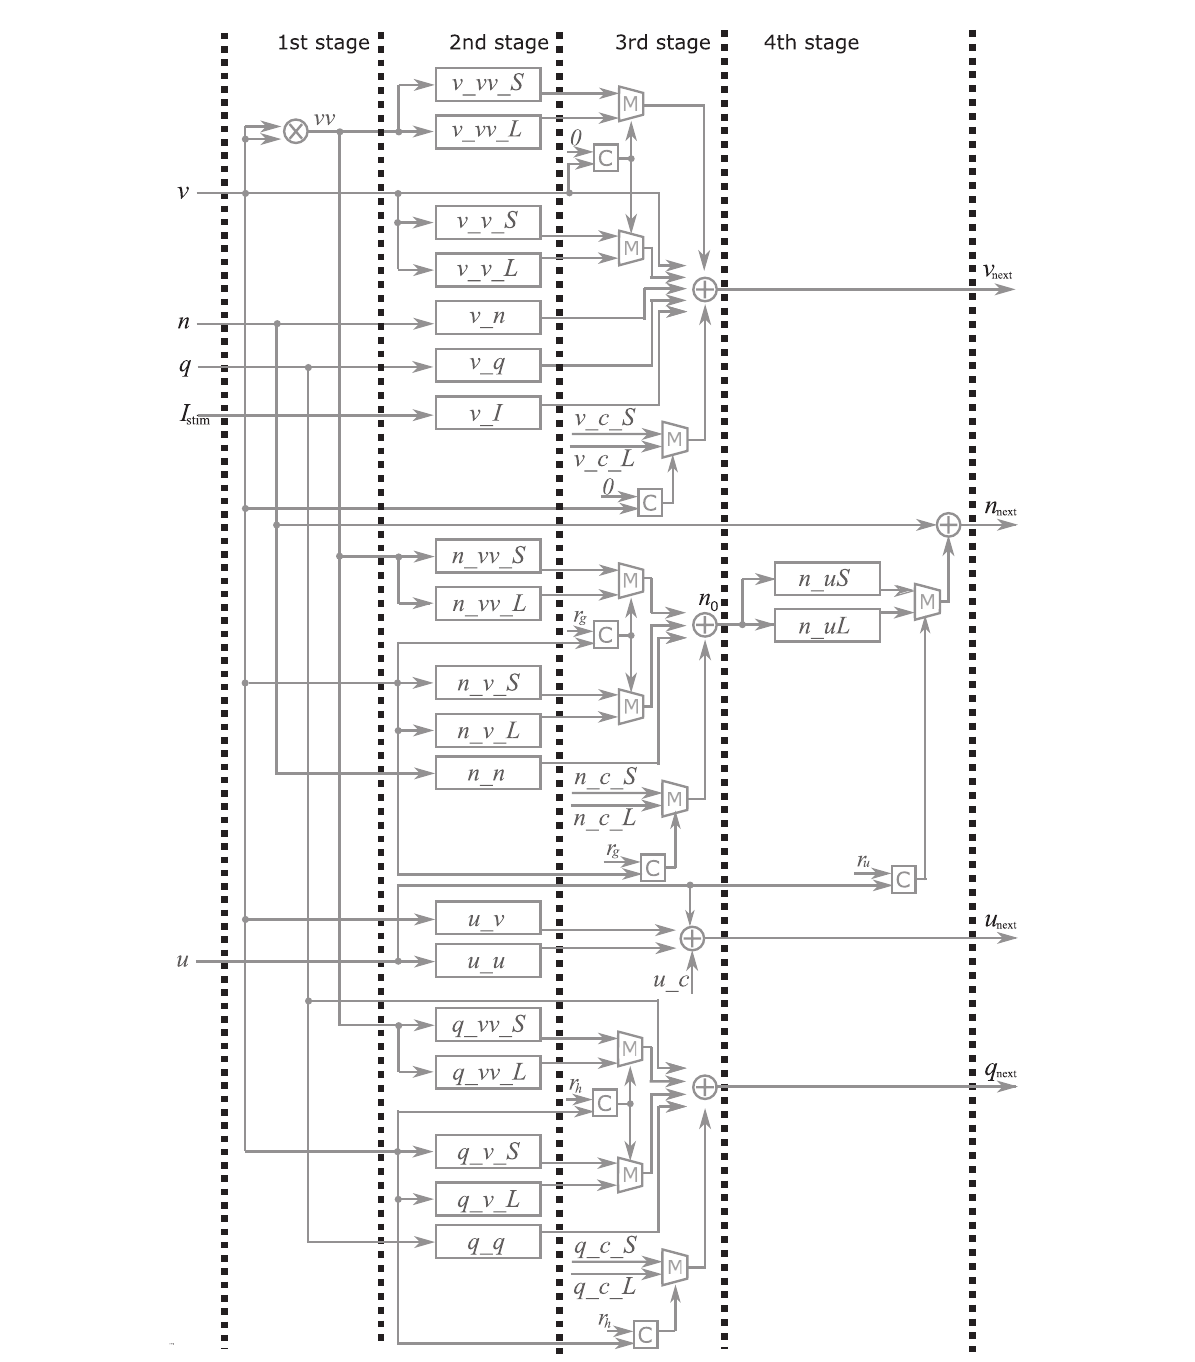
FIGURE2 Block diagram of the PQN engine for the IB and LTS mode. The symbols × , + , M and C represent multipliers, adders, multiplexers, and comparators, respectively. The v , n , q , u and I stim are input for the PQN engine. The output v next , n next , q next , and u next are values of the state variables at the next time